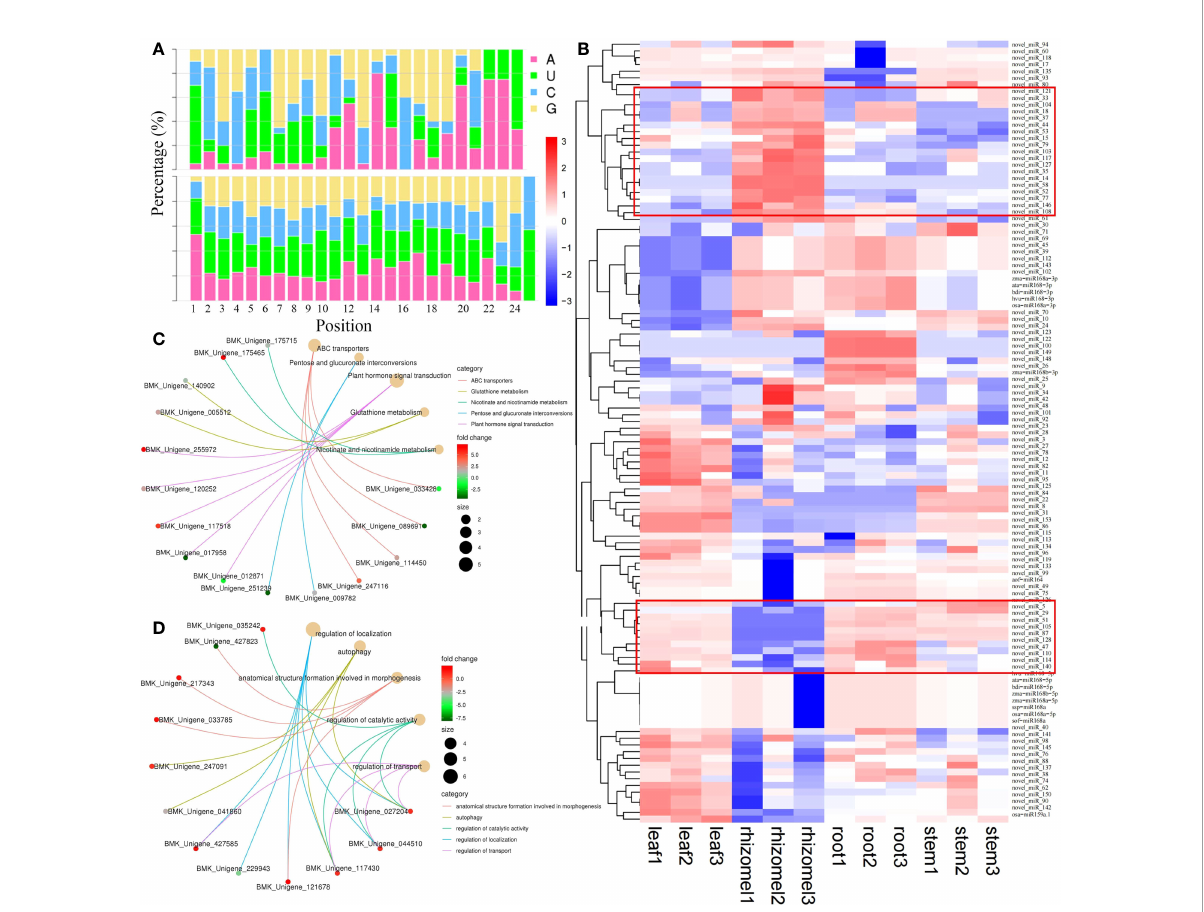
FIGURE 6 Expression analysis of miRNAs and their targets. (A) Base distribution sites of known and novel miRNAs. (B) Heatmap of miRNAs visualizing the changes in the expression pro fi les in different tissues. (C) Enrichment analysis of miRNA target genes in the root vs. rhizome group. (D) GO enrichment analysis of miRNA target genes in the root vs. leaf